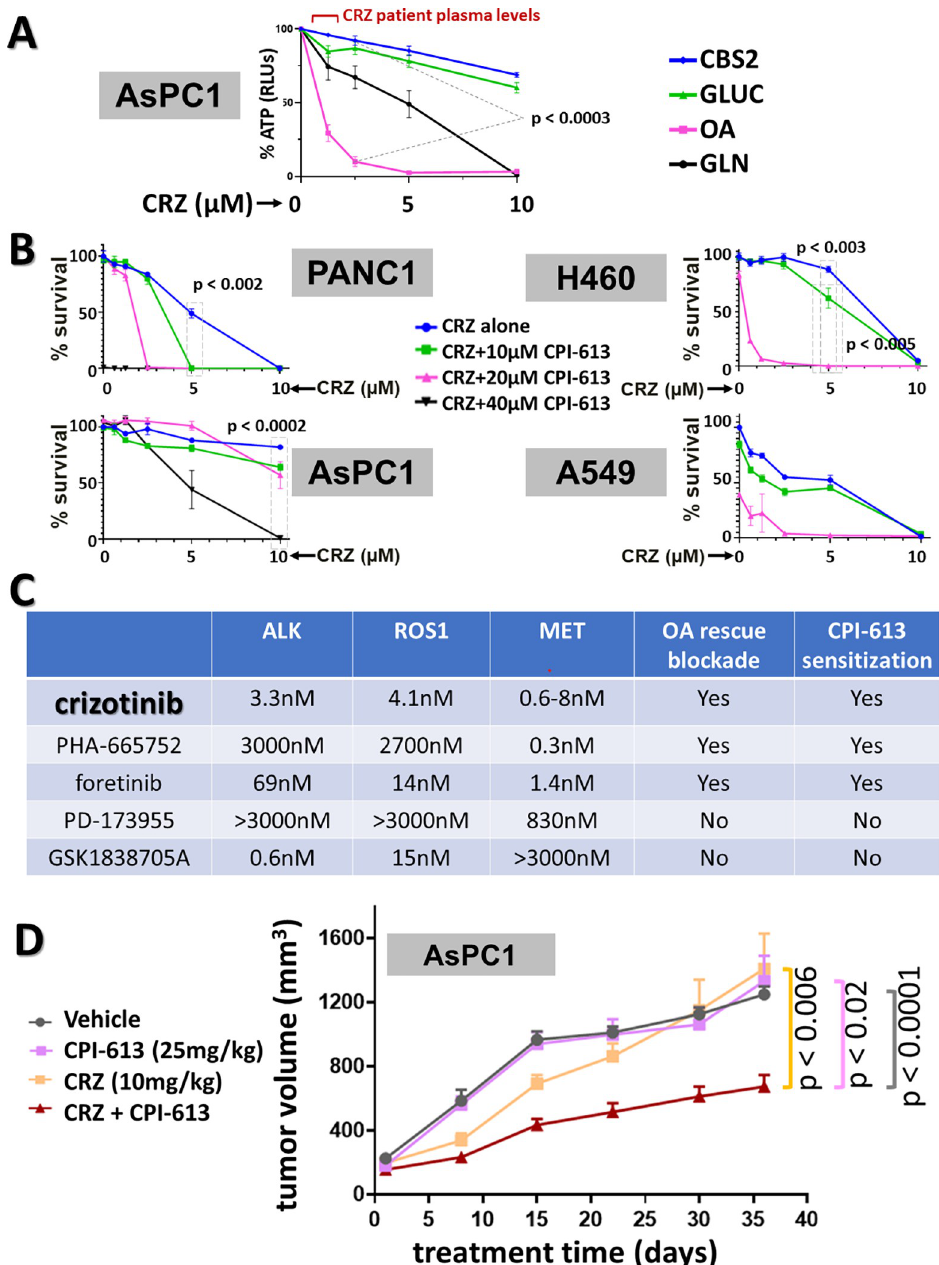
Fig 7. Crizotinib tyrosine kinase inhibitor (RTKi) mimics TZ inhibition of in vitro fatty acid rescue and sensitizes resistant AsPC1 carcinoma cells to CPI-613 in vivo . A: Crizotinib (CRZ) strongly inhibits exogenous OA-driven ATP synthesis in the presence of CPI-613, analogously to TZ (see Fig 3D). AsPC1 cells were treated for 4.5hrs in CBS2 with 50 μ M GPi and 60 μ M CPI-613 to suppress ATP generation from endogenous sources and ATP levels were measured directly (acute response, as in Figs 2E, 3D and 4B). Exogenous carbon sources are as indicated (1 mM glucose; 1 mM GLN; 50 μ M OA). These raw acute ATP readings were normalized to the untreated control for each carbon source (see S5C Fig for the non-normalized data). The CBS2 control contains no CPI-613 or GPi. See Discussion for patient drug levels. B. CRZ can sensitize several carcinoma lines to CPI-613 cell killing in vitro (endogenous nutrient store limited) . Assessment of cell death commitment induced in two PDAC lines (PANC1, AsPC1) and two lung cancer lines (H460, A549) in the absence of exogenous carbon by indicated combinations of CPI-613 and CRZ. Cells were treated for 15hrs in CBS2 followed by 24hrs of CM/ns recovery (compare to Fig 3A). C. RTKi interactions with carcinoma cell CPI-613 response . Summary of analysis of a set of RTKi effects on acute ATP synthesis (as in panel A) and CPI- 613-induced cell death (as in panel B). Primary data summarized here also include those in S5A and S5B Fig. CPI-613